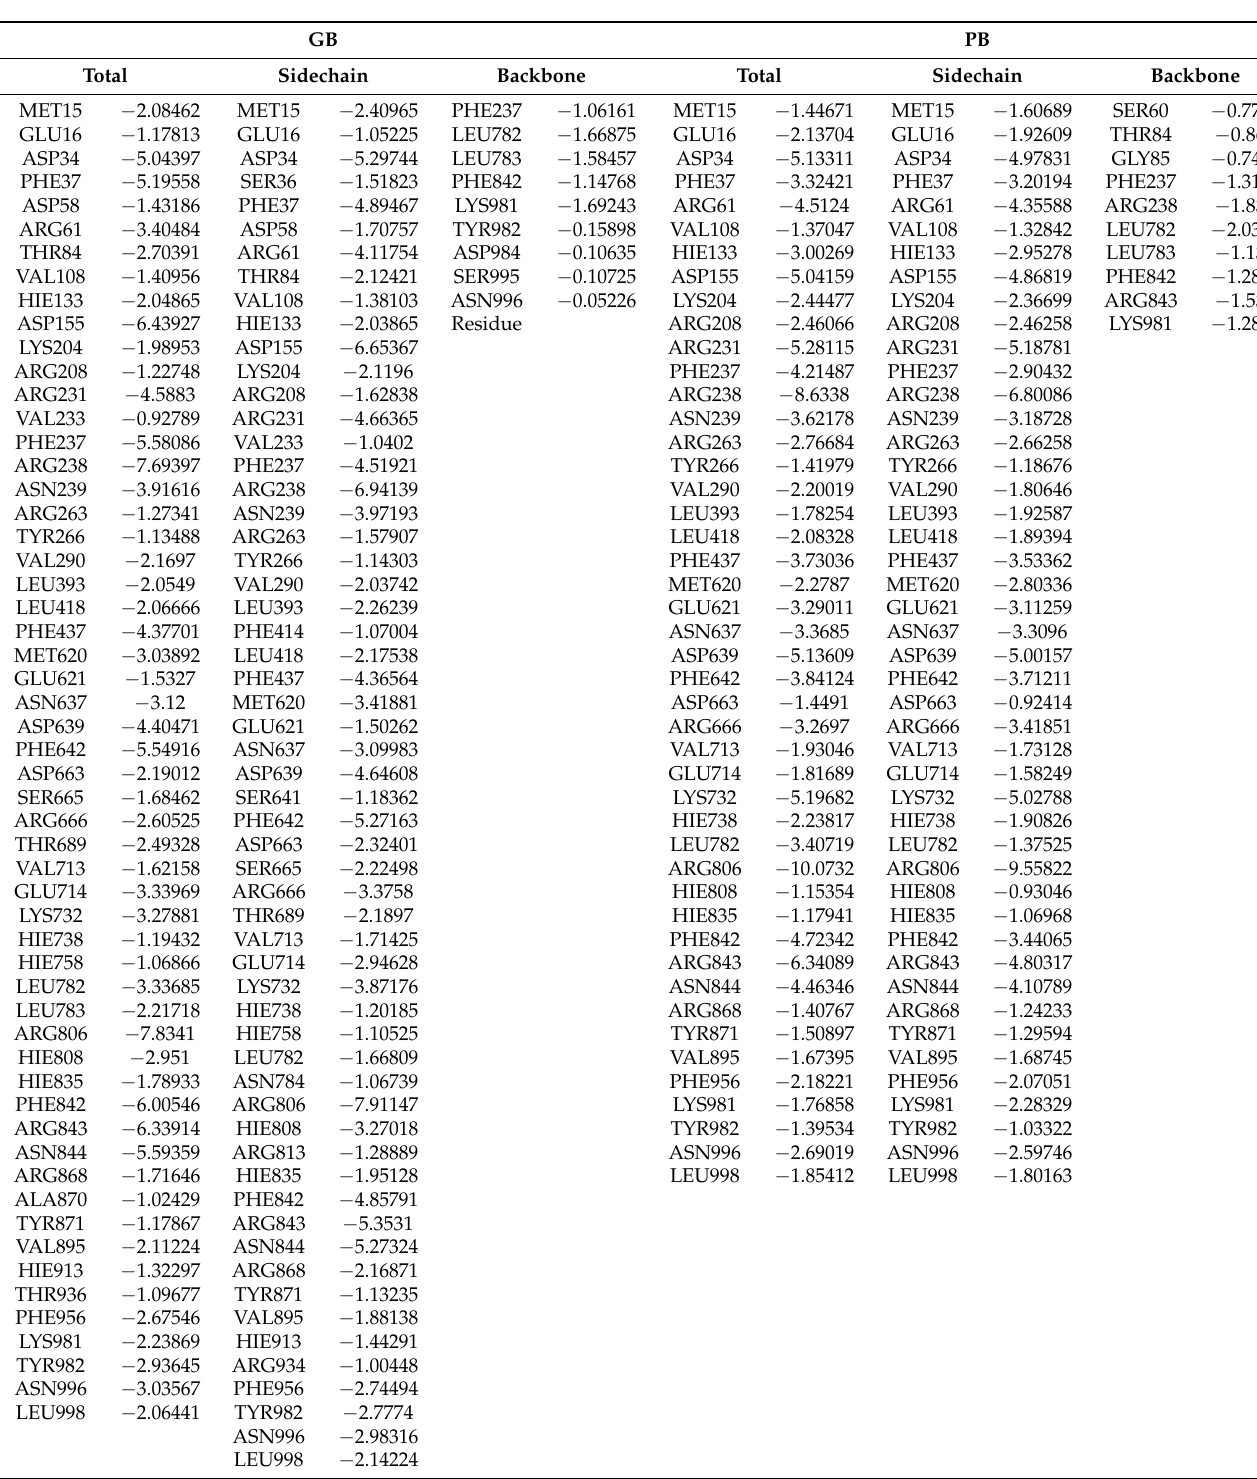
Table 7. Hotspot residues from TLR4 and Vaccine ensemble highly contributes to complex